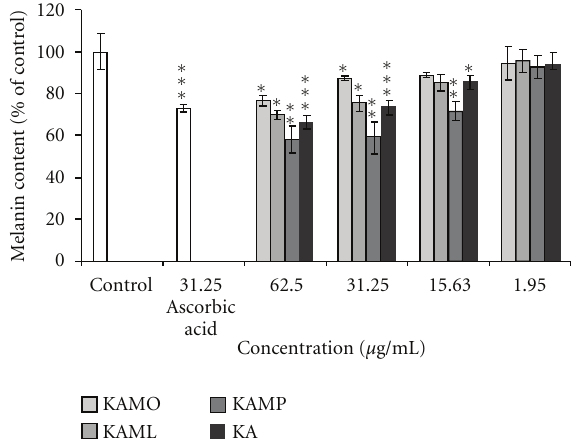
Figure 3: The e ff ects of KAMO, KAML, KAMP, and KA on melanin content in B16F1 melanoma cells. Denotes ∗ P < 0 . 05, ∗∗ P < 0 . 01, ∗∗∗ P < 0 . 001 compared to α -MSH treated control. Data are presented as means ± S.E.M, and expressed as % of control. 31.25 μ g/mL ascorbic acid was used as reference. n ≥ 3.